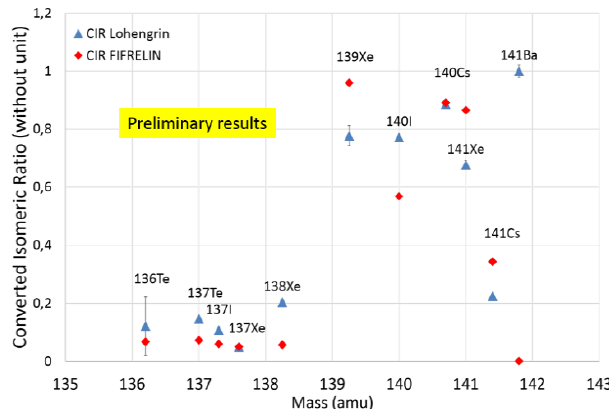
Fig. 6: Converted isomeric ratios as a function of the mass induced by the fission of 241 Pu(n ,f) in comparison to FIFRELIN calculations th